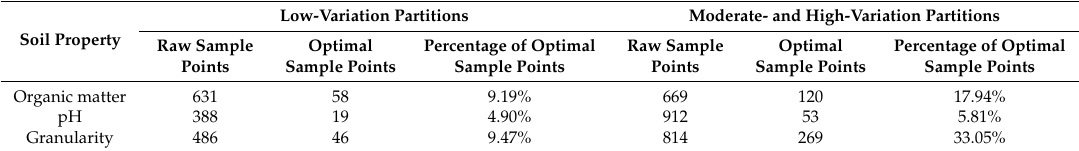
Table 4. Comparison of the optimization results for soil properties in different spatial variation partitions by improved simulated annealing